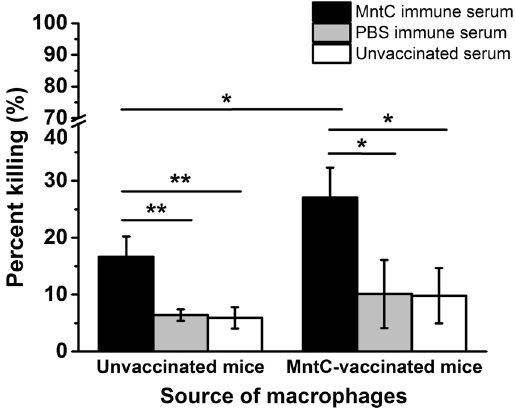
Figure 3. Opsonophagocytic activity mediated by immune sera from mice immunized with MntC. BALB/c mice (n = 5) were immunized with MntC or PBS, sera was separated. Source of peritoneal macrophages was MntC-vaccinated mice and unvaccinated mice respectively. 10 µ L immune sera, 5 × 10 5 mouse peritoneal macrophages and 1 × 10 6 CFUs S . aureus Newman were incubated in round-bottomed six-well plates for 30 min before treating with agglutination lysis buffer and plating on TSA for CFUs. Then the percentage of phagocytosis was counted. PBS-vaccinated sera were used as negative control, and untreated sera were used as blank control. Significant differences were indicated by ( * P < 0.05), ( ** P < 0.01) and ( *** P < 0.001).